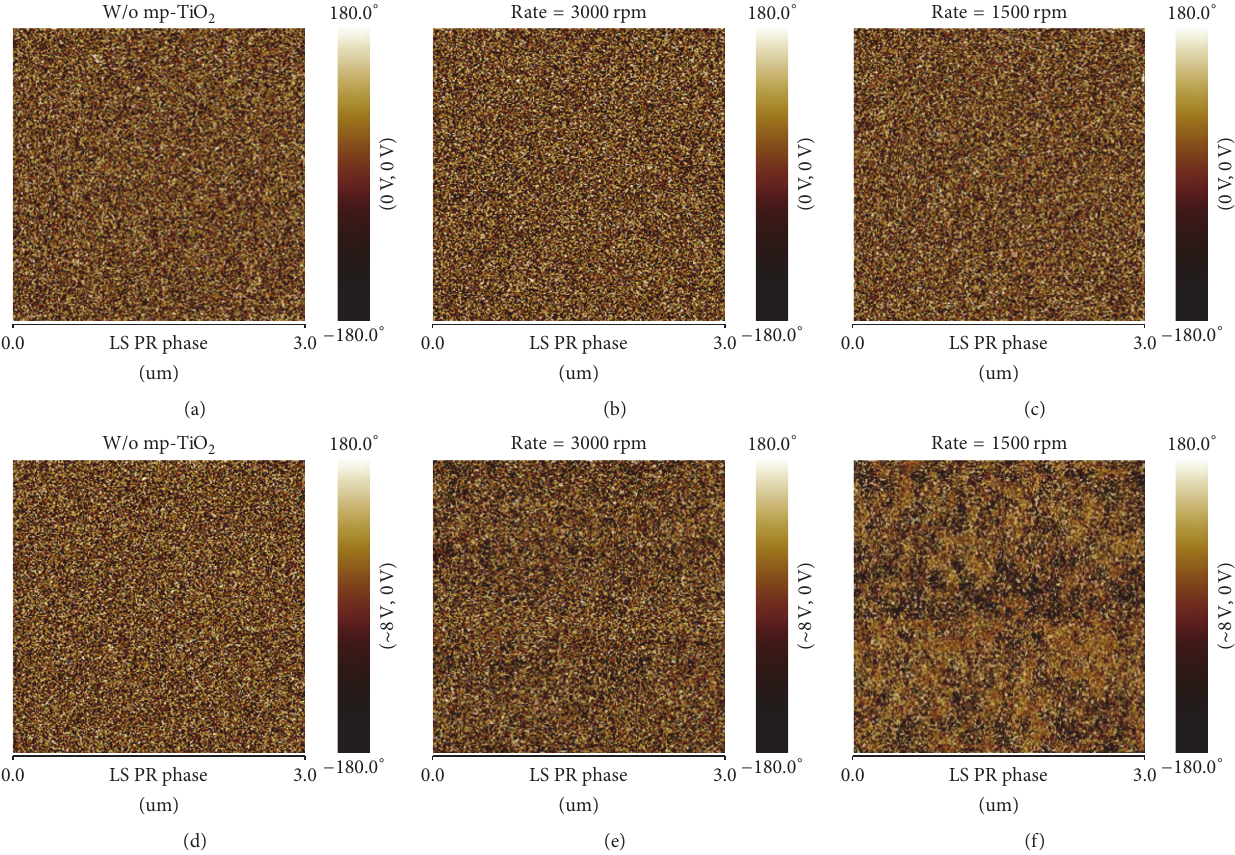
Figure 4: PFM phase images of the CH 3 NH 3 PbI 3 perovskite films which applied (0V, 0V) (a) w/o mp-TiO 2 layer and (b) with the spin- coating rate of the mp-TiO 2 precursor for 3000 rpm and (c) with the spin-coating rate of the mp-TiO 2 precursor for 1500 rpm. PFM phase images of the CH 3 NH 3 PbI 3 perovskite films which applied ( ∼ 8V, 0V) (d–f) correspond to those which applied (0V, 0 V) without mp-TiO 2 layer and with the different spin-coating rates of the mp-TiO 2